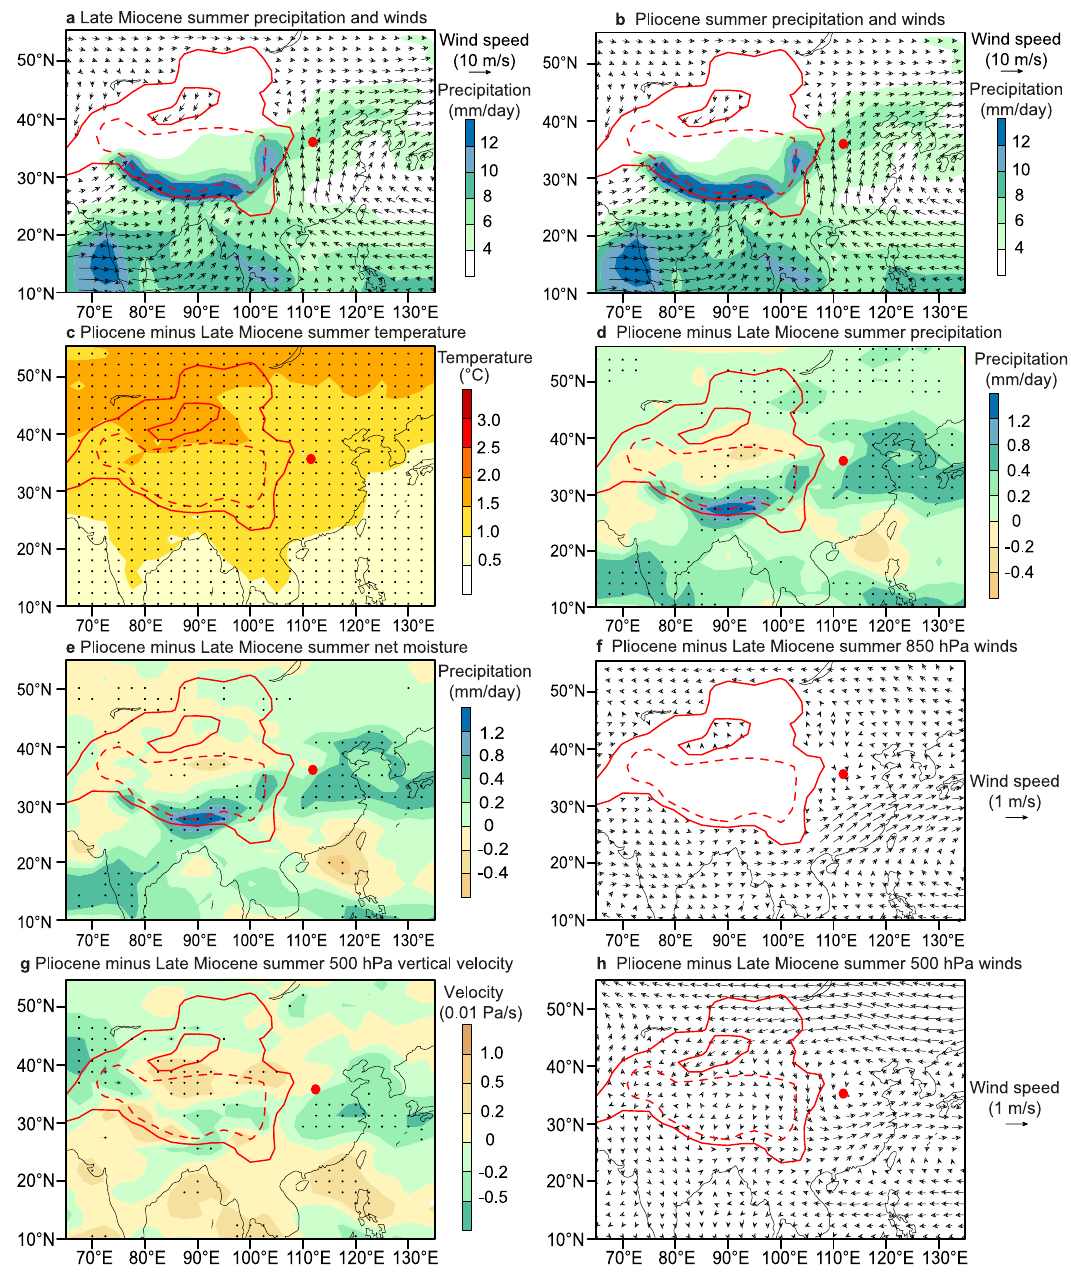
Fig. 6 Simulated Asian climate and atmospheric circulation responses to CO 2 increase across the MPB. Simulated summer precipitation (shading) and 850 hPa winds (black vectors) for a late Miocene (280 ppm CO 2 ) and b Pliocene (400 ppm CO 2 ) experiments. Simulated changes (Pliocene minus late Miocene) of summer c surface air temperature, d precipitation, e net moisture (precipitation minus evaporation), f 850 hPa winds (summer monsoon), g 500 hPa vertical velocity, and h 500 hPa winds (westerly jet), due to CO 2 increase from the late Miocene level of 280 ppm to the Pliocene level of 400 ppm. Solid and dashed red inland contours in (a – h) denote 1500 and 3000 m topographic contours, respectively. Negative (green) and positive (yellow) shades in g represent increasing atmospheric ascending and descending fl ows, respectively. Note that stronger atmospheric ascending and descending fl ows generally result in more and less precipitation, respectively. The red dot indicates the location of the Shilou section. Black dots in c – e and g denote regions statistically signi fi cantly above the 95% con fi dence level (Student ’ s t -test). Summer is represented by May to